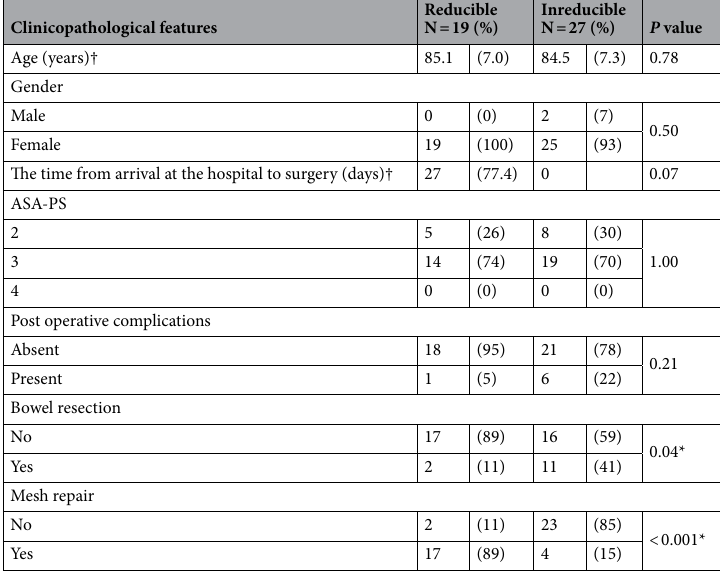
Clinicopathological